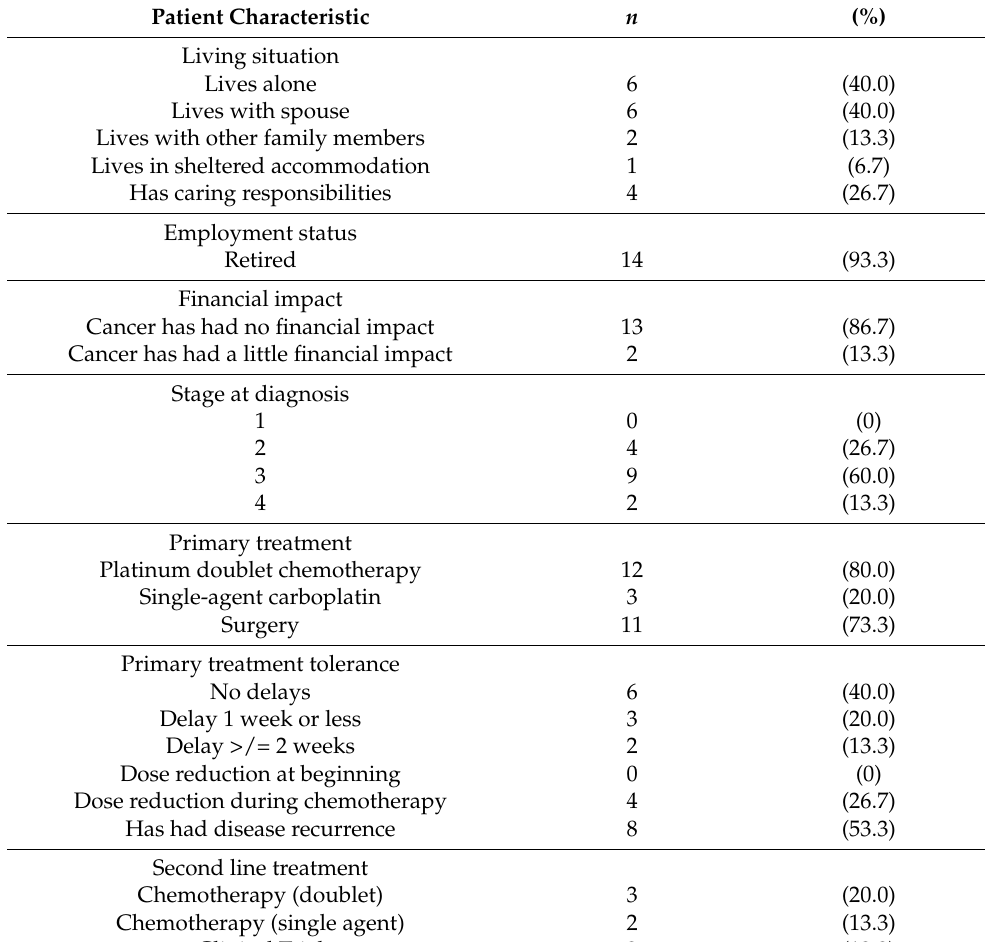
Figure 1. Flowchart of participant recruitment. Table 2. Patient